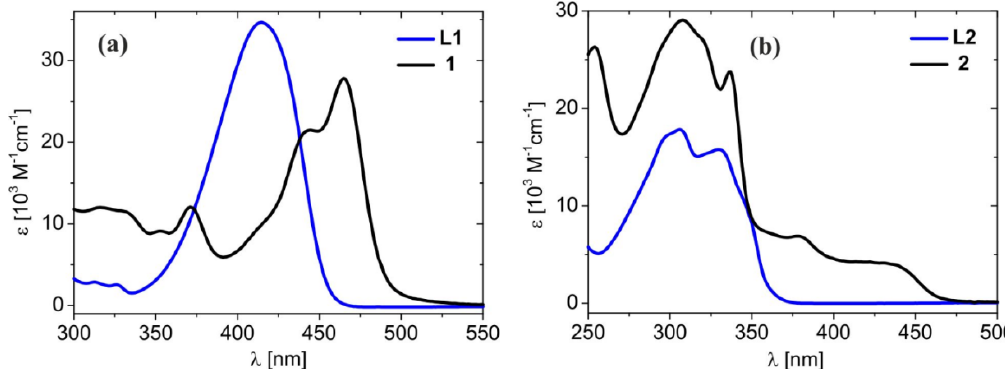
Figure 4. Comparison of the electronic absorption spectra of ( a ) L1 and 1 ; ( b ) L2 and 2 in CH 2 Cl 2